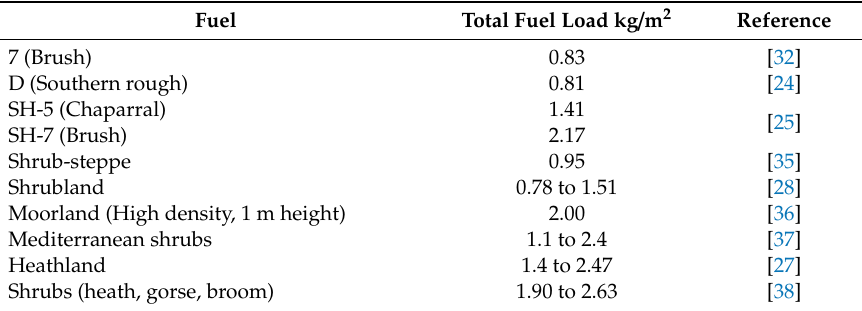
Table 3. Fuels chosen for intensive green